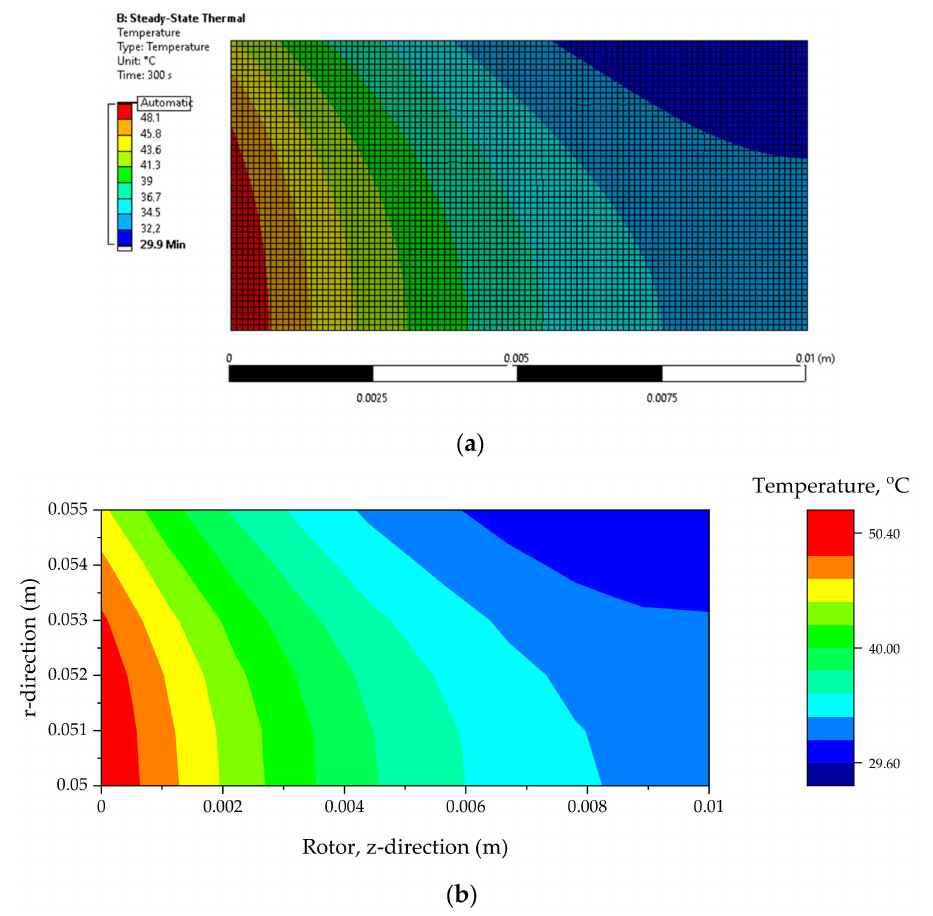
Figure 6. Temperature distribution in the rotor calculated by ( a ) the Ansys Workbench model and ( b ) the proposed model for t = 300 s.